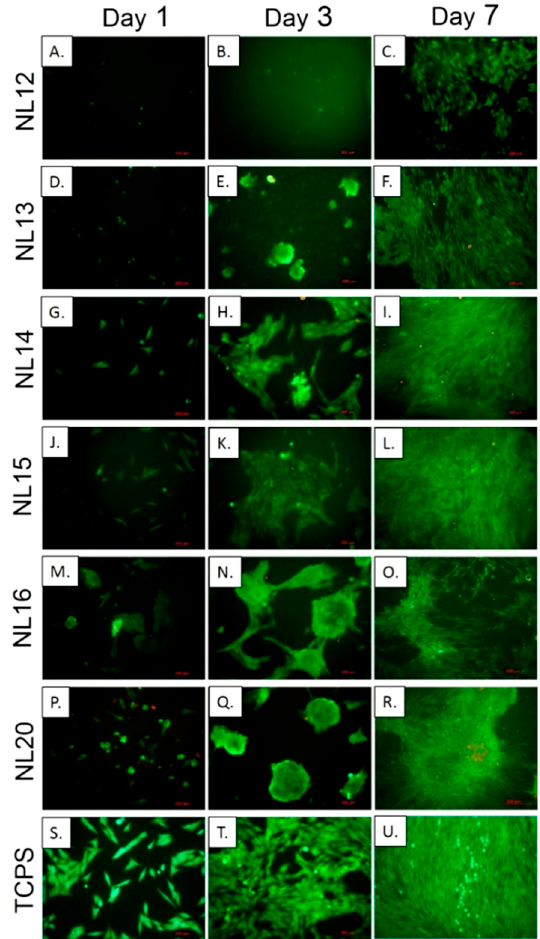
Figure 13. MG-63 cell morphology cultured for 1, 3 and 7 days on different polymers and controlled GTCPS, staining with calcein AM and propidium iodide; green—live cell, red—dead cell.